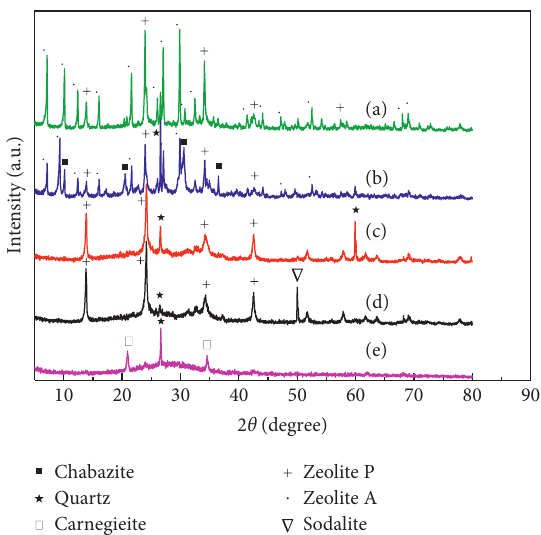
Figure 2: XRD patterns of the synthesized zeolites under various reaction temperatures: (a) 100 ° C; (b) 90 ° C; (c) 80 ° C; (d) 60 ° C; (e) 40 ° C (synthesis conditions: initial Si/Al ratio, 1.5; reaction time,